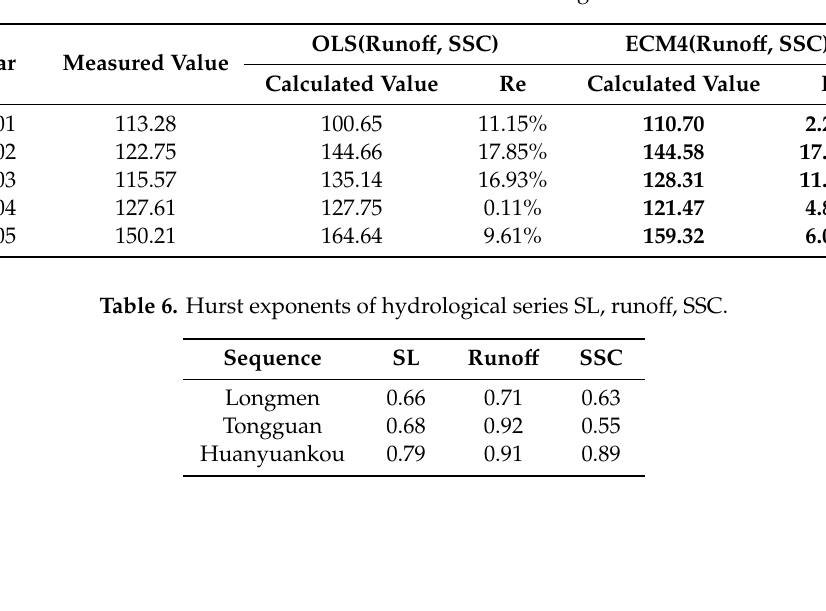
Table 5. Predicted results of runo ff at Toudaoguai station.